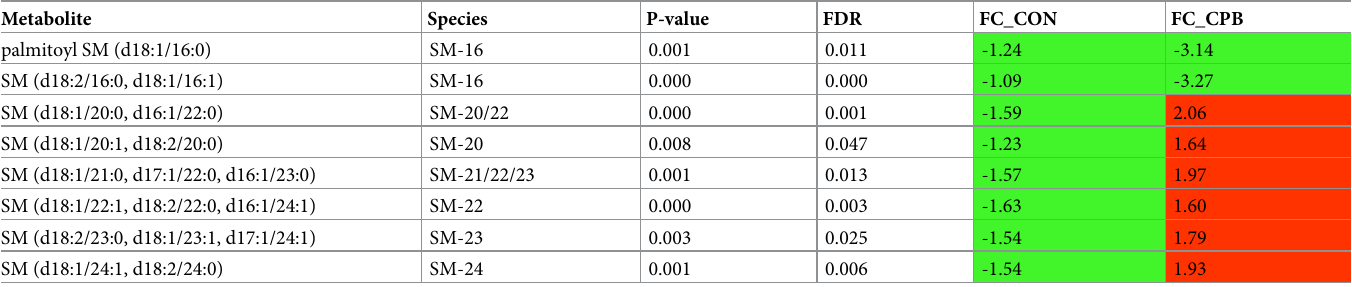
Table 2. Sphingomyelin species with long chain saturated fatty